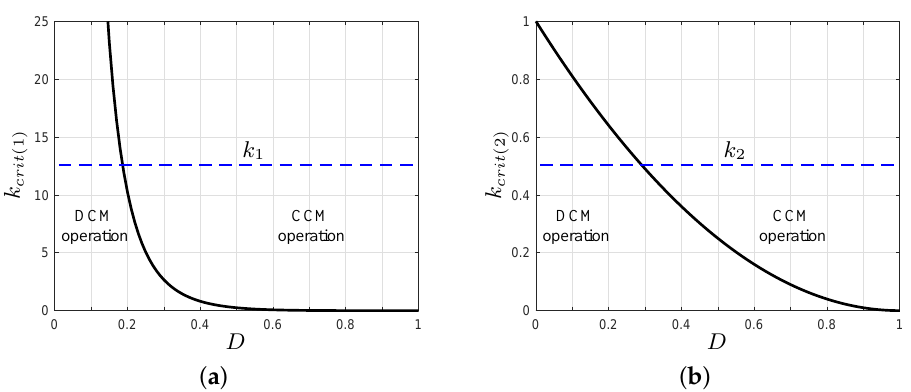
Figure 5. Boundary operation of the proposed converter under parameter variations: ( a ) parameter k crit ( 1 ) ; ( b ) parameter k crit ( 2 )